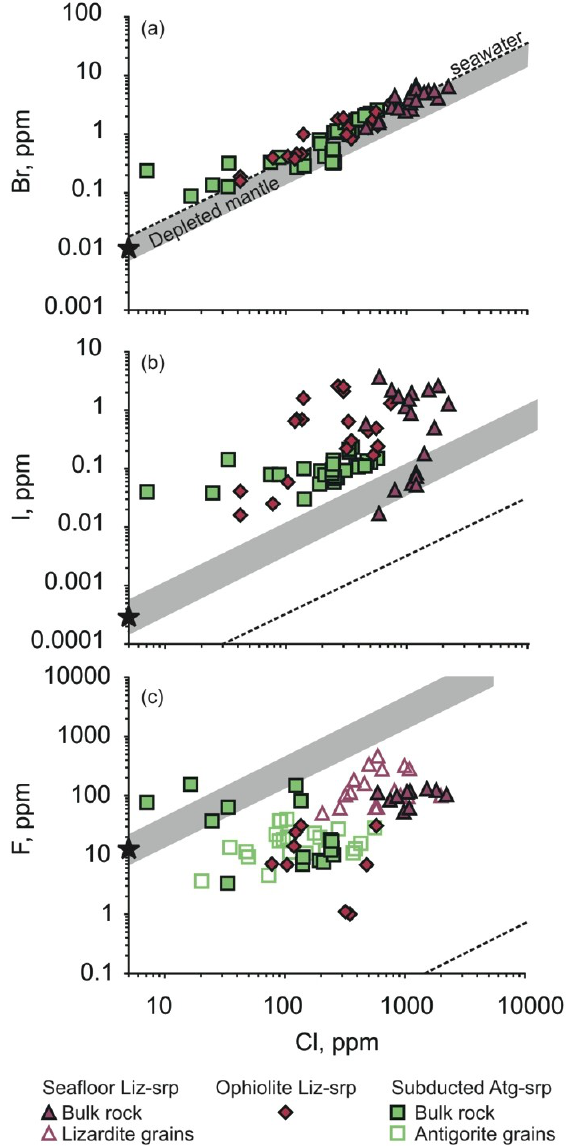
Figure 3. Halogen concentrations of seafloor and obducted abyssal lizardite serpentinites (Liz srp) and subducted antigorite serpentinites (Atg srp). Bulk serpentinite data are from [43,44,49,53]. In situ data of serpentine grains are from [34,43]. The F/Cl, Br/Cl and I/Cl ratios of the depleted mantle (grey fields) [6] and seawater (dashed lines) [54] are shown, along with the average concentrations of F, Cl, Br and I in the depleted mantle (black stars) [6]. Figures modified after [55]. ( a ) Bromine and Cl concentrations in all serpentinites are elevated with respect to the average depleted mantle but are strongly correlated along a linear trend defined by the Br/Cl ratio of the mantle and seawater, suggesting their coherent behaviour during serpentinization (hydration) and subduction (dehydration). On average, the obducted abyssal serpentinites having lower Br and Cl concentrations than the seafloor samples, and the subducted serpentinites have lower concentrations than the obducted samples. ( b ) All samples have elevated I concentrations with respect to the depleted mantle, and most samples also have I/Cl ratios greater than the mantle. Iodine and Cl broadly correlate among the seafloor and obducted abyssal serpentinites. The seafloor and obducted abyssal serpentinites have similar I concentrations, while their subducted counterparts extend to lower values. ( c ) Individual lizardite grains have higher F content than antigorite, but bulk rock values for lizardite- and antigorite serpentinites are similar. The higher F content of some subducted serpentinites may indicate an influx of F during antigorization from other dehydrating lithologies.